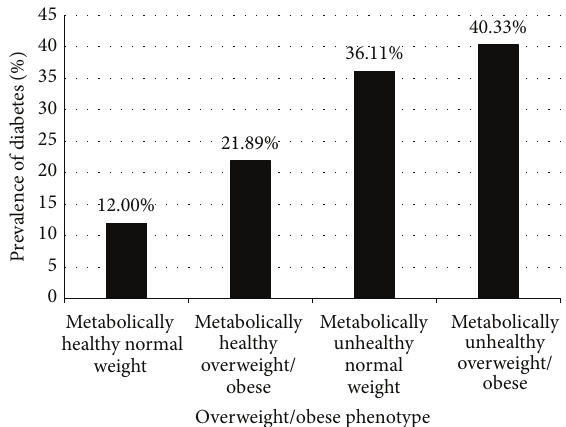
Figure 1: Prevalence of diabetes among Mexican Americans within each overweight/obese phenotype. Black bars indicate prevalence rate. Diabetes prevalence was different by overweight/obese pheno- type ( 𝑃 < 0.0001